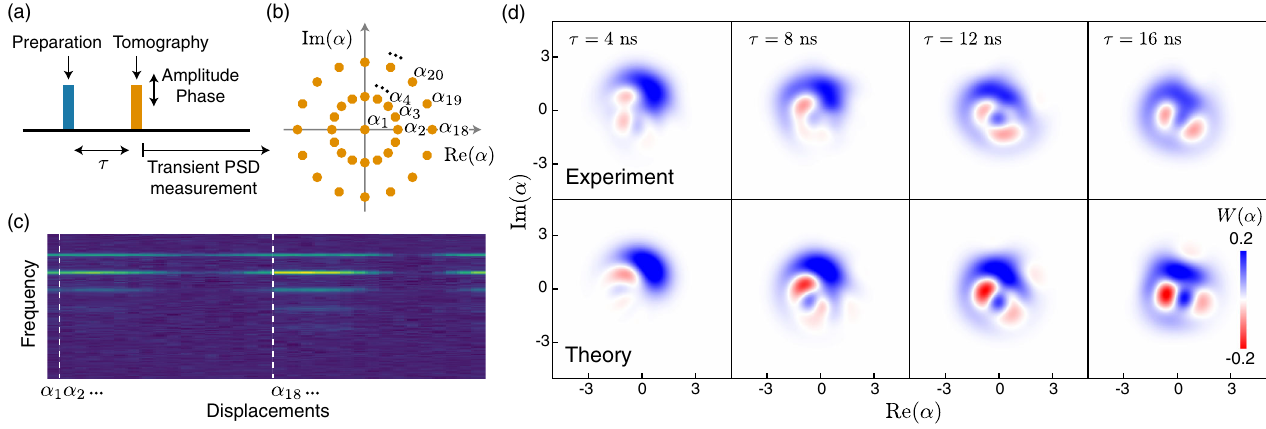
FIG. 3. Schematic of the tomography and time evolution of a coherent state under Kerr nonlinearity. The tomography pulses are (a) delayed by τ from the state preparation pulse and (b) swept in phase space with two different amplitudes, which corresponds to displacements with 16 different phases and two different amplitudes of about 0.5 and 1.0. (c) An example tomography data set for a coherent state ( τ ¼ 0 ). (d) Time evolution of the system ’ s Wigner function W ð α Þ at four different time slices τ , starting from a coherent state at τ ¼ 0 . The distortion in phase space is caused by the Kerr nonlinearity and is reproduced by simulations. The fidelities of the reconstructed states compared with simulated ones are 0.93, 0.92, 0.90, and 0.89,